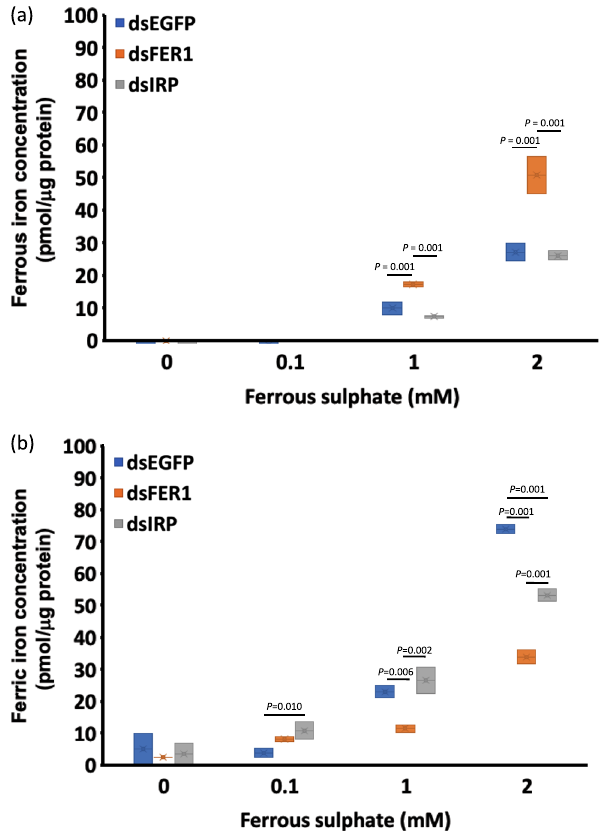
Figure 4. ( a ) Box and whisker plot showing the distribution of ferrous iron concentration of knocked down ISE6 cells exposed to different concentrations of ferrous sulphate as determined by ferrozine assay. Cleared lysates from knocked down ISE6 cells exposed to different concentrations of ferrous sulphate, and the concentration was determined using a Micro BCA Protein Assay Kit. Ferrous iron was determined using a ferrozine assay in the absence of a reducing agent. A one-way ANOVA with Bonferonni multiple comparison tests was performed (Tables S8 and S9) ( b ) Box and whisker plot showing the distribution of ferric iron concentration of knocked down ISE6 cells exposed to different concentrations of ferrous sulphate as determined by ferrozine assay. Cleared lysates from knocked down ISE6 cells exposed to different concentrations of ferrous sulphate, and the concentration was determined using a Micro BCA Protein Assay Kit. Ferric iron was determined using the ferrozine assay by determining the difference between the total and ferrous iron concentrations. A one-way ANOVA with Bonferonni multiple comparison tests was performed (Tables S11 and S12). The data presented are results of three independent experiments with the ferrozine assay performed in two technical replicates for each experiment.